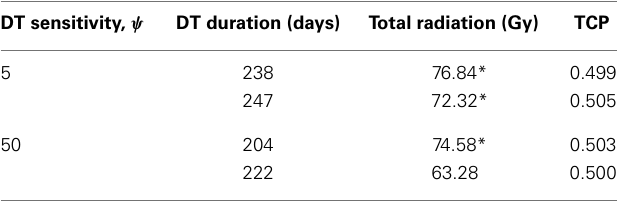
Table 4 |A selection of breast cancer tumor treatment parameters resulting inTCP ≈ 0.5.